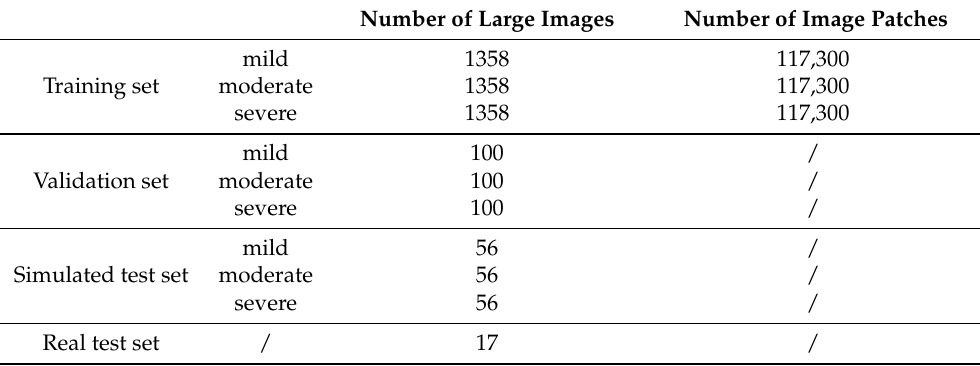
Figure 7. Some training data. From left to right: clear; mildly degraded; moderately degraded; and severely degraded. Table 1. Composition details of